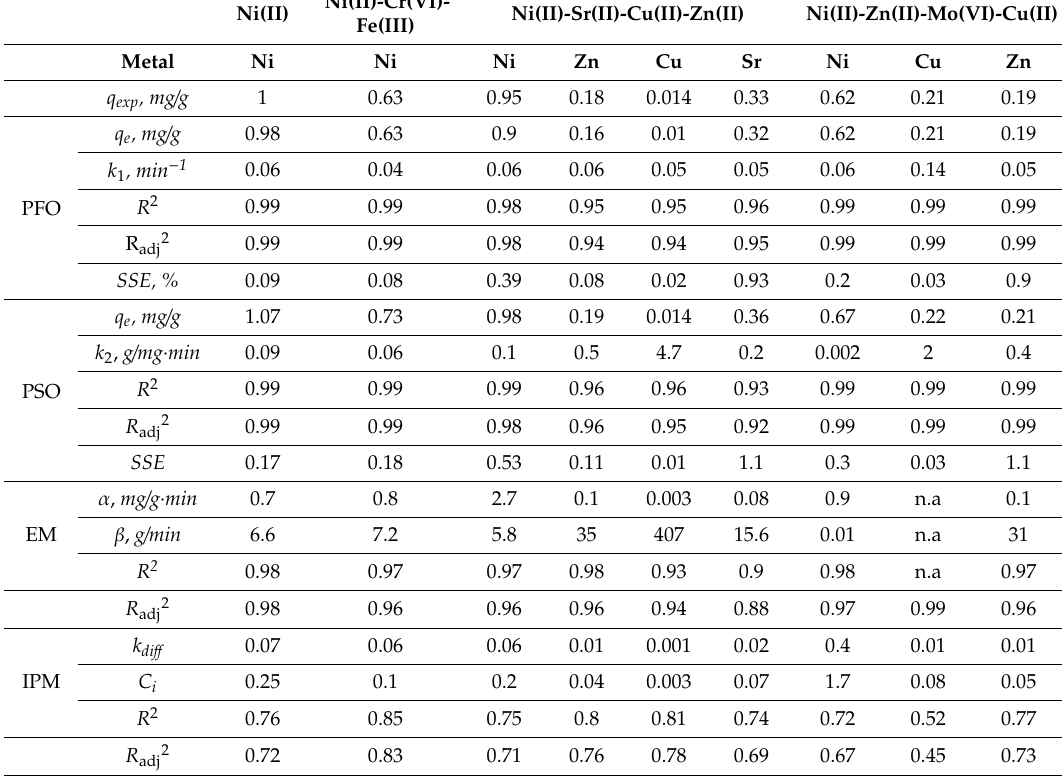
Table 4. Parameters calculated from the applied